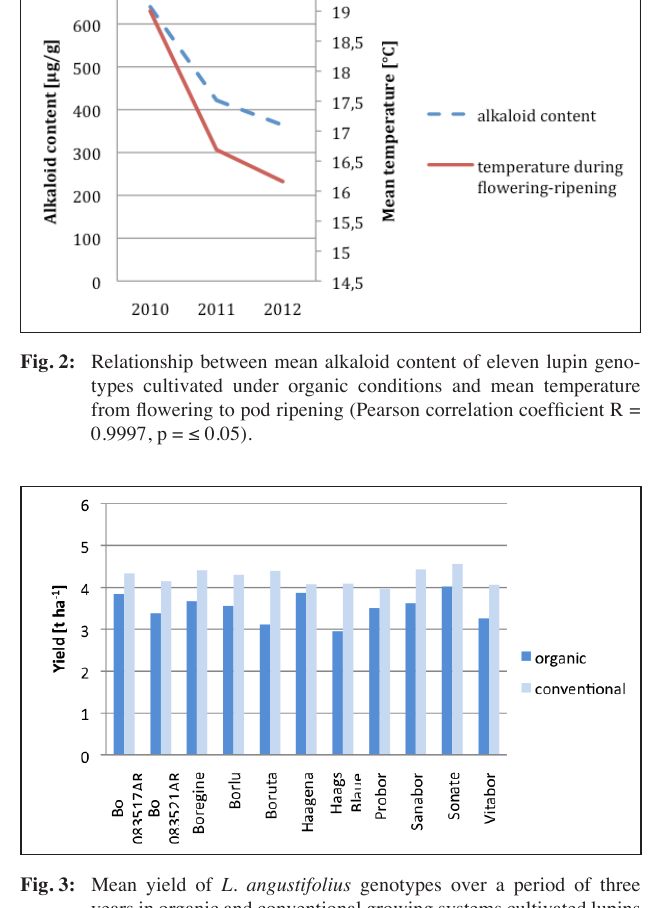
Fig. 3: Mean yield of L. angustifolius genotypes over a period of three years in organic and conventional growing systems cultivated lupins (all varieties had significantly different LS-means-values, with the exception of ‘Haagena’).